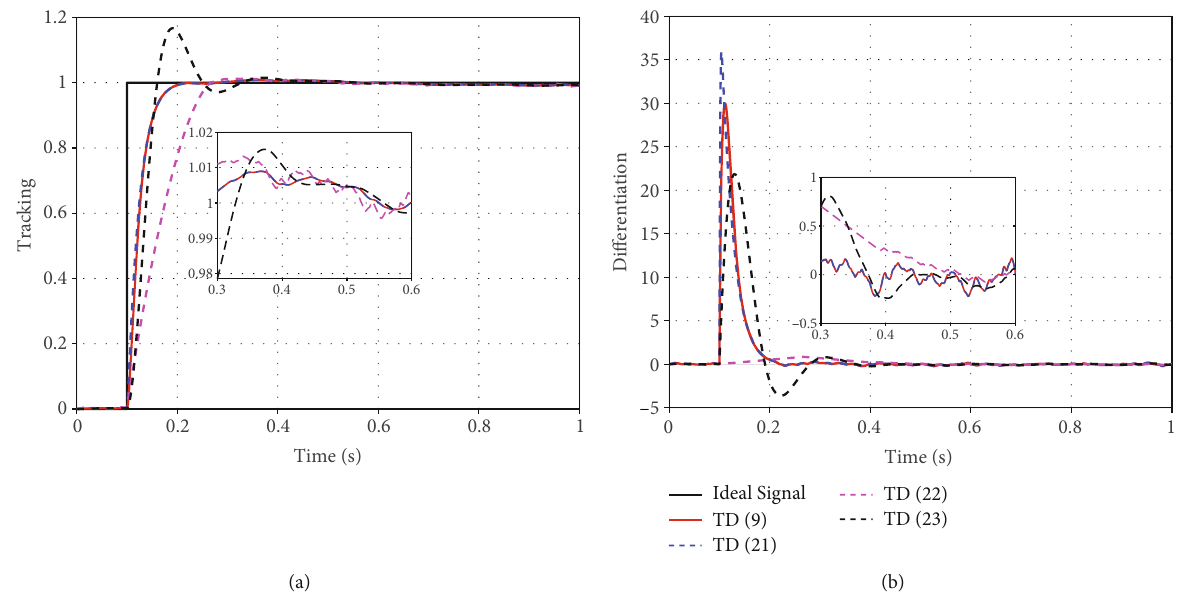
Figure 1: The tracking performances of TD: (a) tracking signal and (b) di ff erentiation signal.